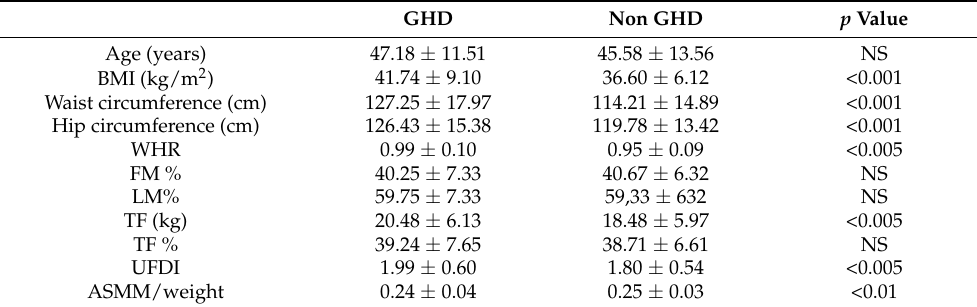
Table 2. Comparison of general characteristics, anthropometrics and body composition parameters between GHD patients and the control group (patients with normal GH